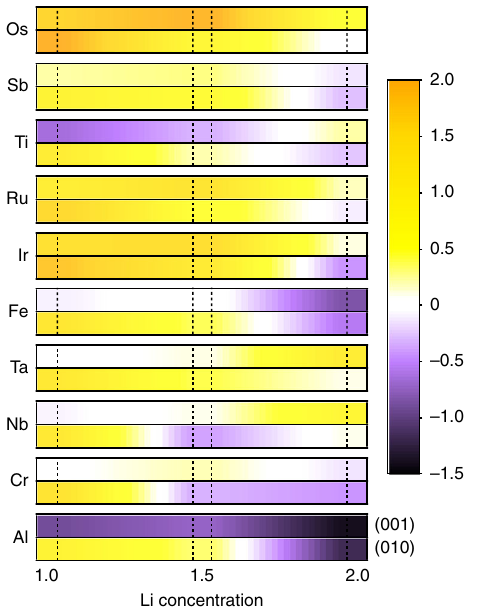
Fig. 3 The relative surface oxygen release energies. The top 10 candidate dopants contained surfaces compared to the pristine systems shown for representative (001) and (010) surface facets. A dark yellow color indicates stronger oxygen retention, while a purple color indicates less protection against oxygen release as compared to the pristine, undoped